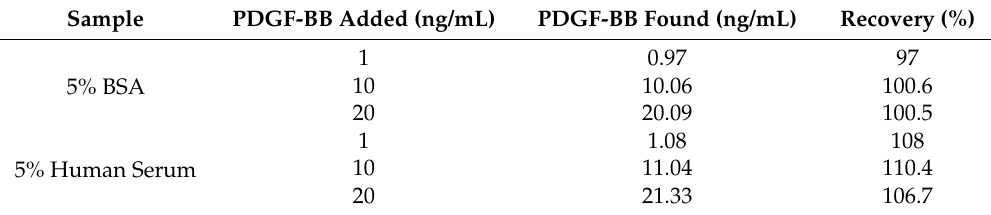
Table 1. Results of the recovery test of PDGF-BB in 5% BSA and 5% human serum using the proposed